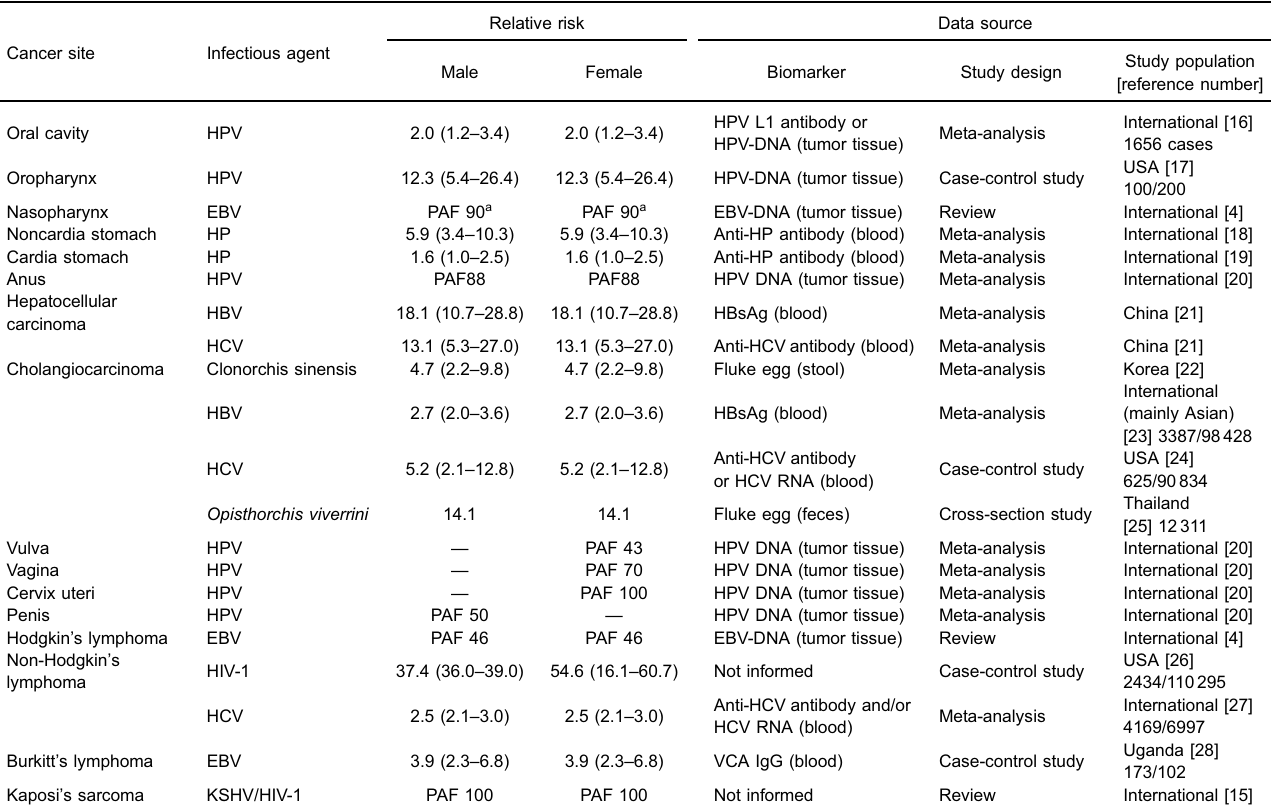
Table 2. Summary of applied relative risks and data